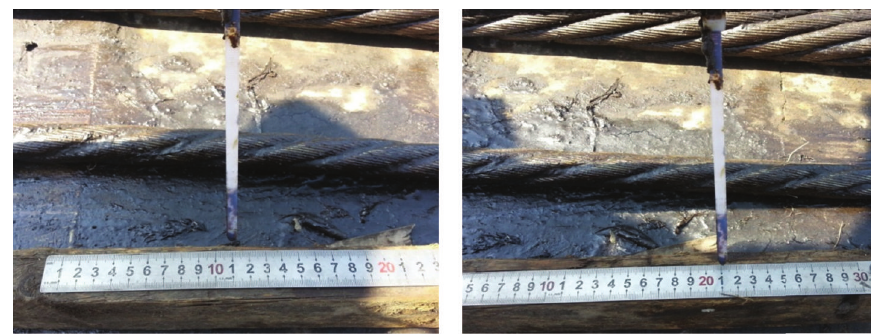
Figure 11: The result of wire rope draw-in at 0.1m.